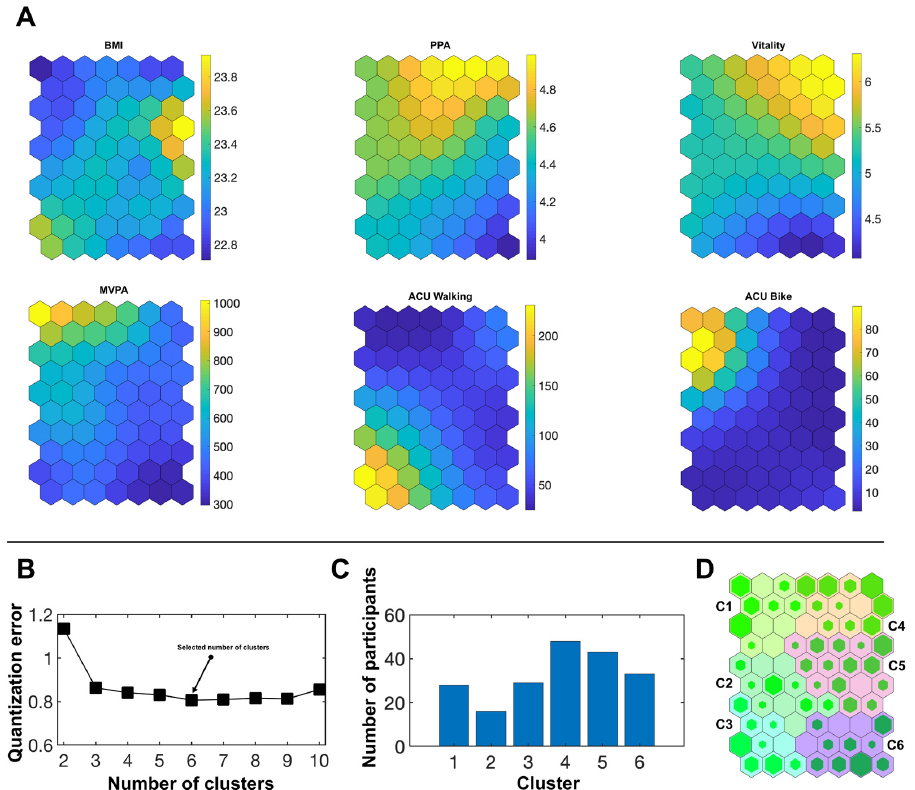
Figure 2. Neuron networks, superordinate clusters and hits obtained by the SOM analysis in the male subsample. ( A ) Neuron networks for the SOM input variables. Yellow color represents the highest values of the sample distribution for each variable, dark blue color represents the lowest values. ( B ) Quantization error according to the possible number of clusters selected. ( C ) Number of participants per cluster for the chosen cluster solution. ( D ) Hits map with the six superordinate clusters C1–C6. The more a neuron is filled with green, the higher the number of participants assigned to the neuron. BMI = body mass index, PPA = perceived physical ability, MVPA = moderate-to- vigorous physical activity, ACU = active commuting to and from university. Table 4. Pairwise comparisons between men’s clusters.